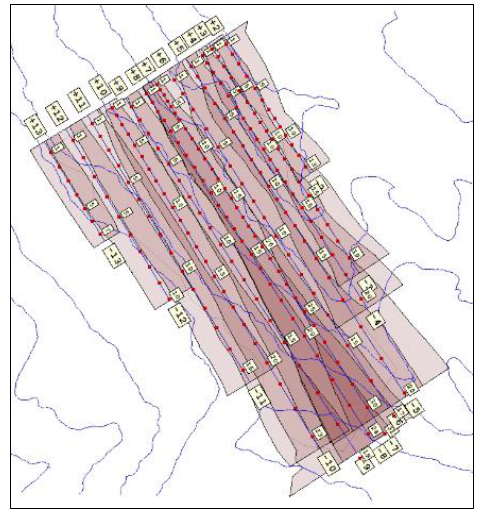
Figure 2. Flightplan geometry, 12 flightstrips presenting 60% and 30% of forward and sidelap coverage, respectively.